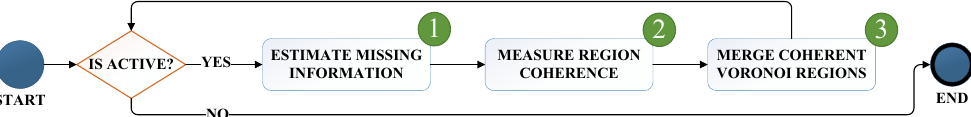
Figure 1. Sketch of the proposed